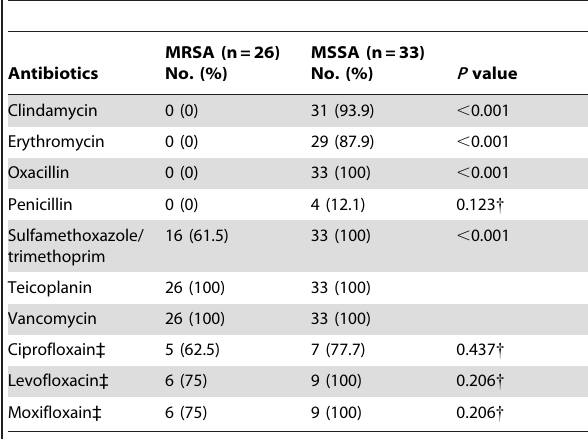
Table 2. Clinical findings of MRSA and MSSA keratitis. Clinical findings